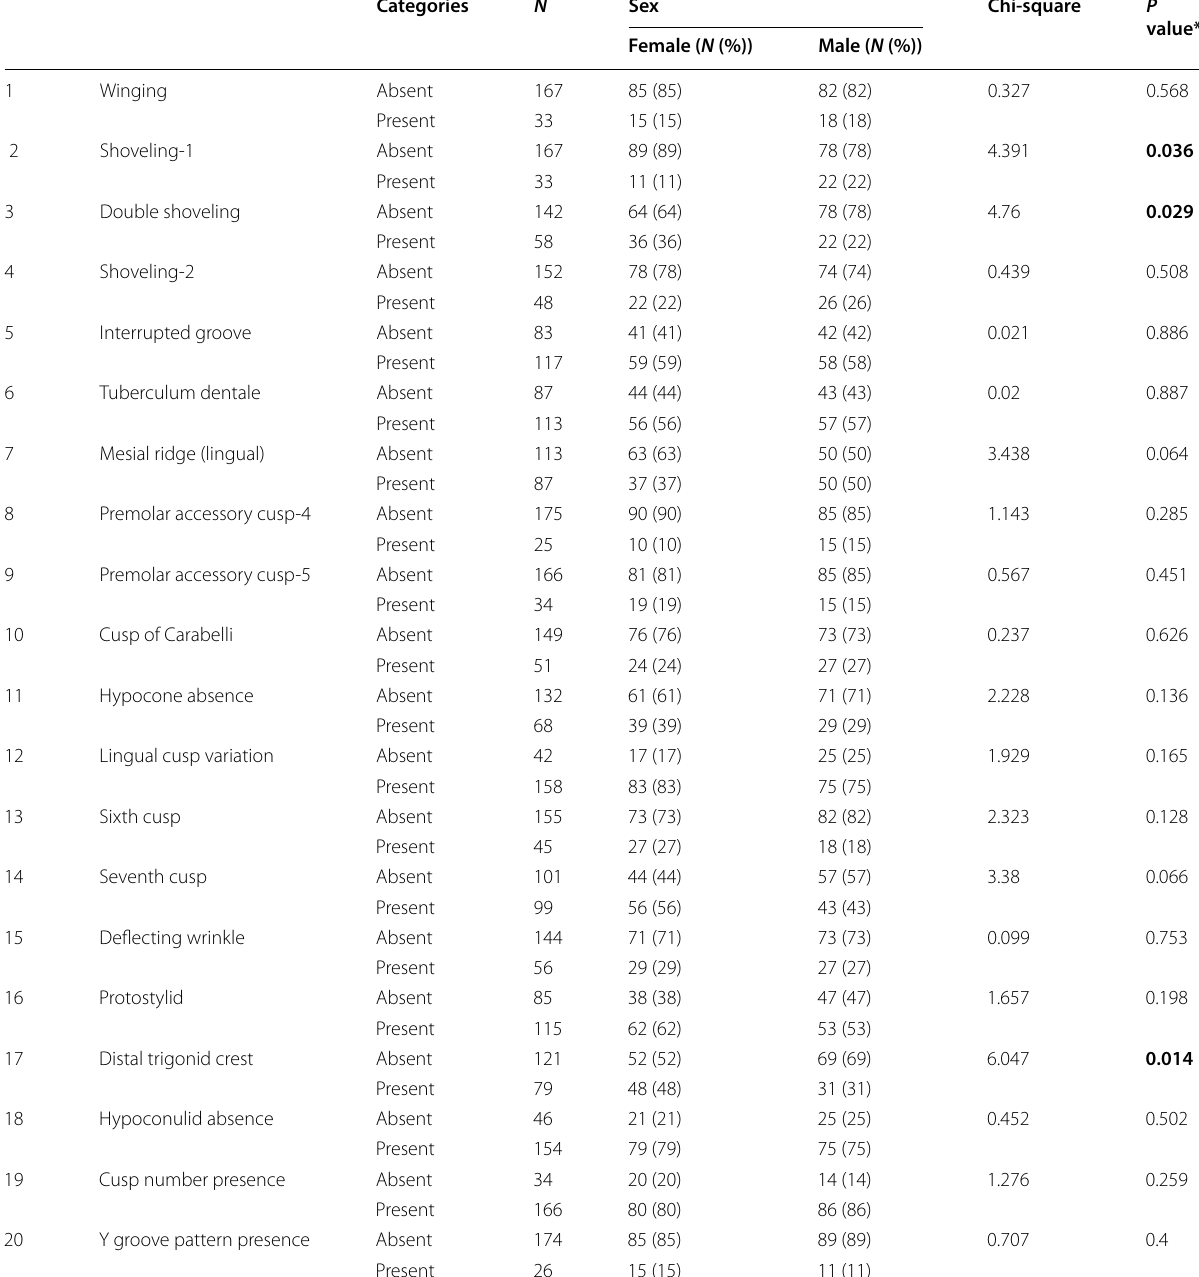
Table 4 Chi-square test for dichotomy expression of non-metric dental